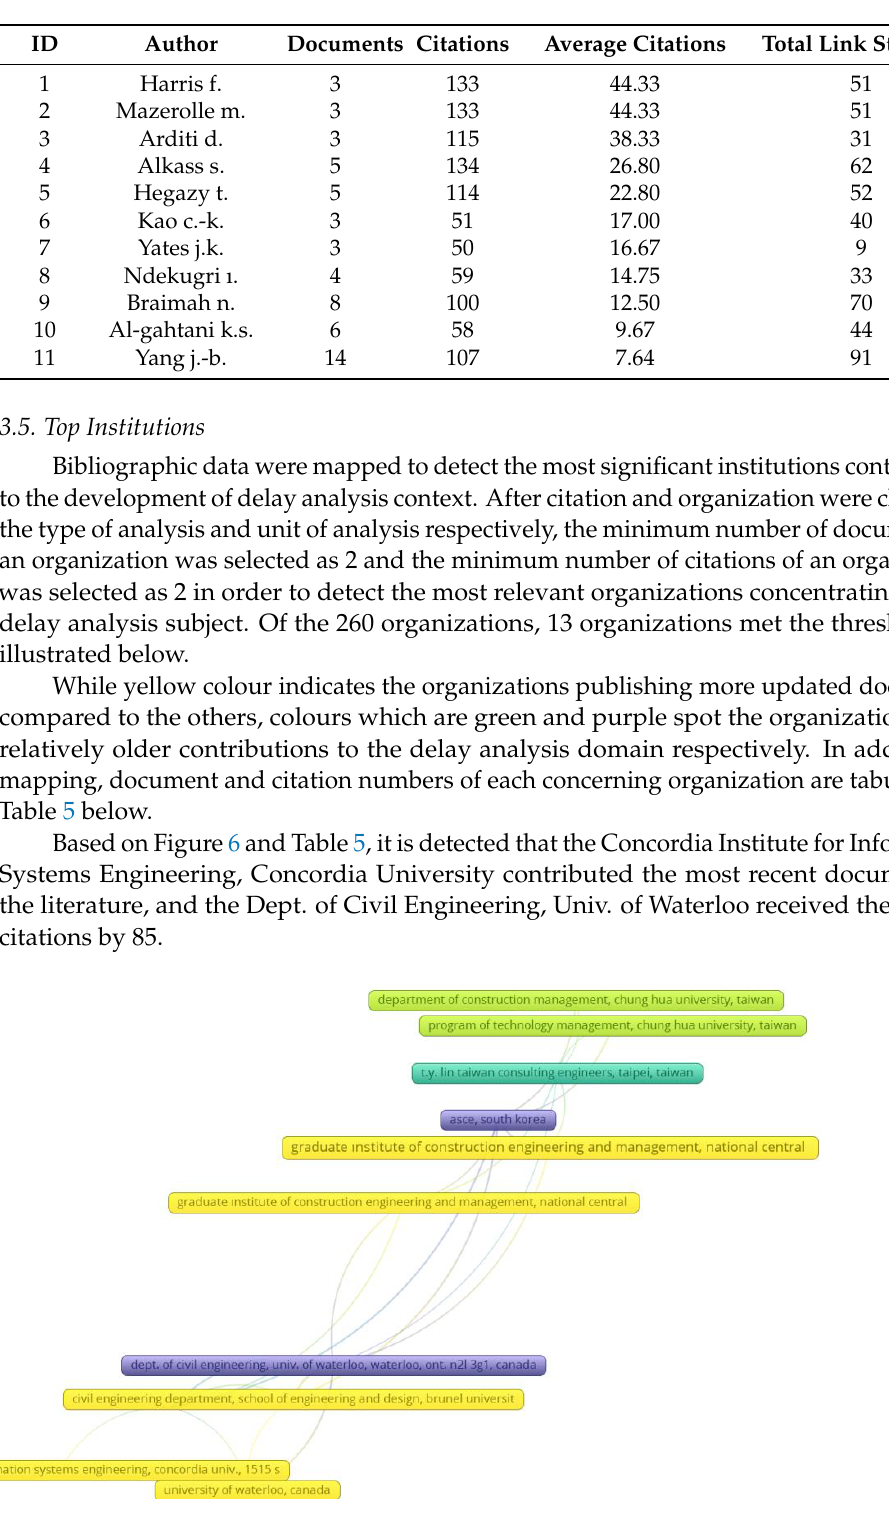
Table 6. The magnitudes concerning document and citation as per countries. ID